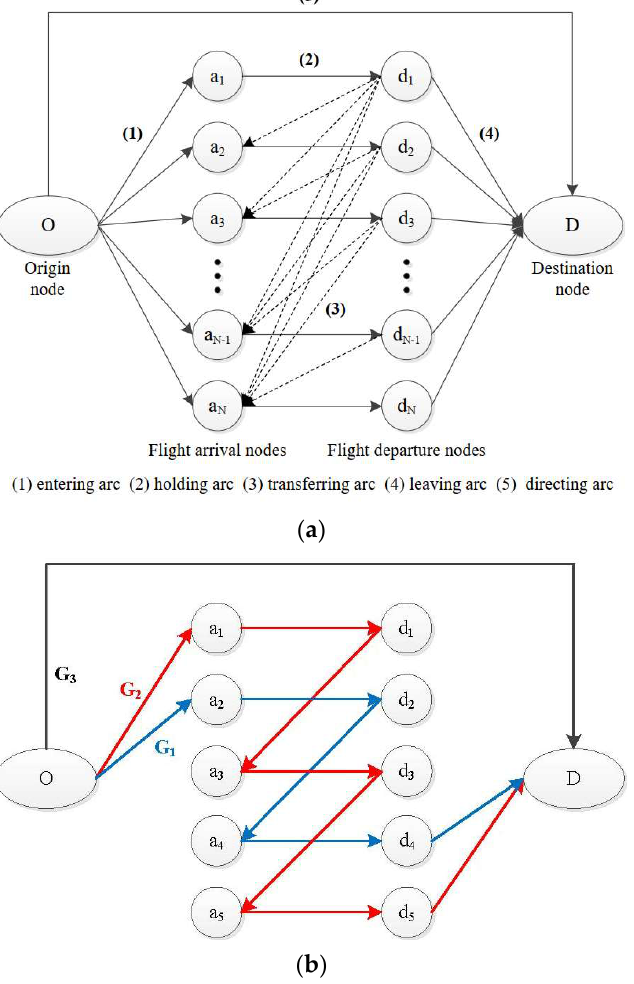
Figure 1. Multi-commodity network flow model for gate allocation. ( a ) The basic paradigm. ( b ) An example of the allocation result with three gates and five flight pairs.